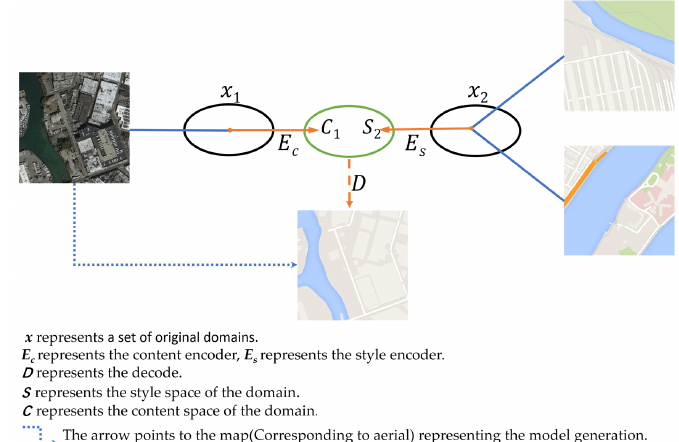
Figure 1. The core of the SAM-GAN model. x 1 represents the source domain (aerial image), and x 2 represents the target domain (map). C 1 represents the content space of the aerial image, and S 2 represents the style space of the map. Different types of encoders can separate the content space or style space from the domain, while decoders must combine the content space and style space.